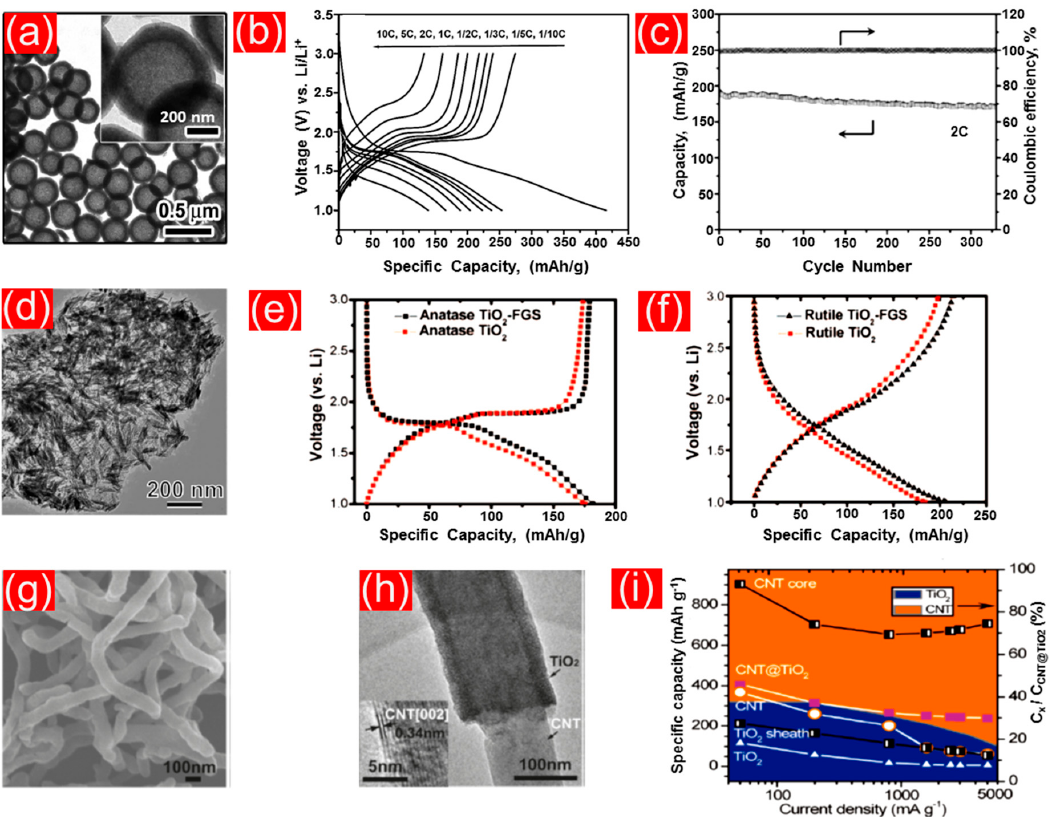
Figure 5. ( a ) Scanning electron microscopy (SEM) image of TiO 2 /C shells, ( b ) first discharging/charging voltage profiles at different current densities, and ( c ) cycling performance, adapted with permission from ref. [72]. ( d ) SEM image of TiO 2 -functionalized graphene sheet hybrids and their voltage profiles for ( e ) anatase and ( f ) rutile phases, adapted with permission from ref. [73]. ( g) SEM and ( h ) transmission electron microscopy (TEM) micrographs of TiO 2 -coated carbon nanotubes (CNTs) and ( i ) their cycling performance, adapted with permission from ref. [74].